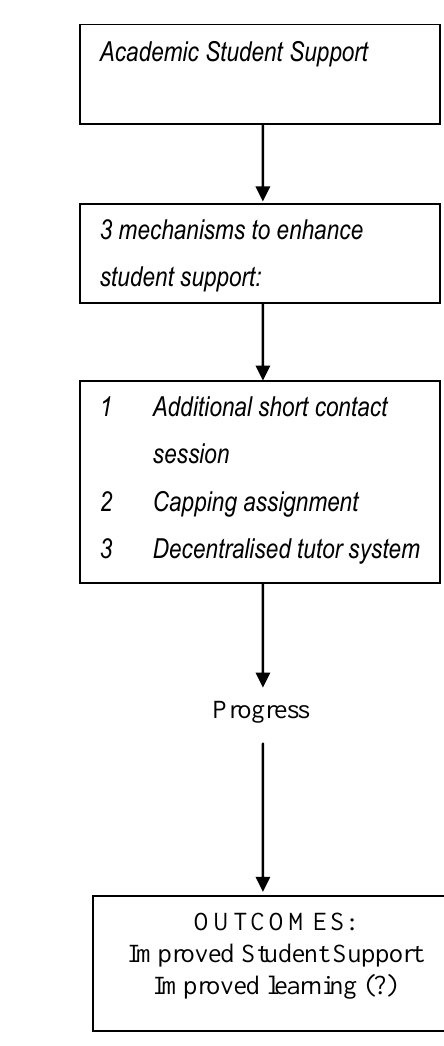
Figure 4 . Improvement plan for the re-design of the Advanced Certificate in Education (ACE) programme (Source: Van der Bank,